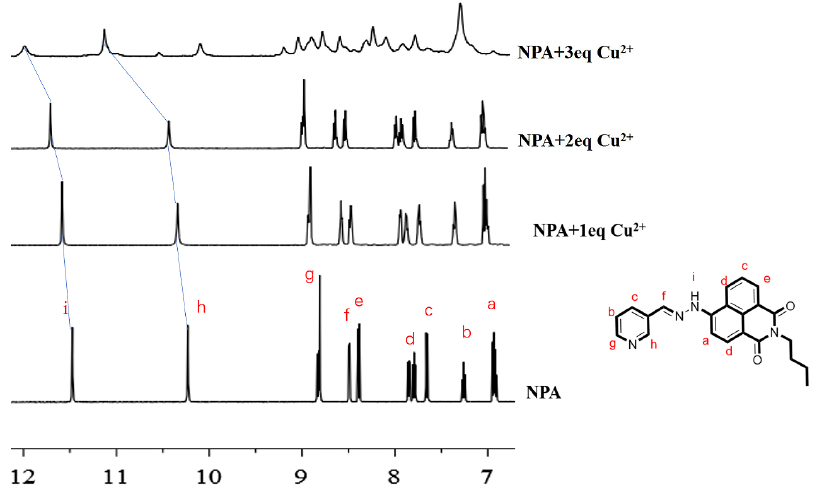
Figure 4. The FT−IR spectra of NPA compound before and after the introduction of Cu 2+ .